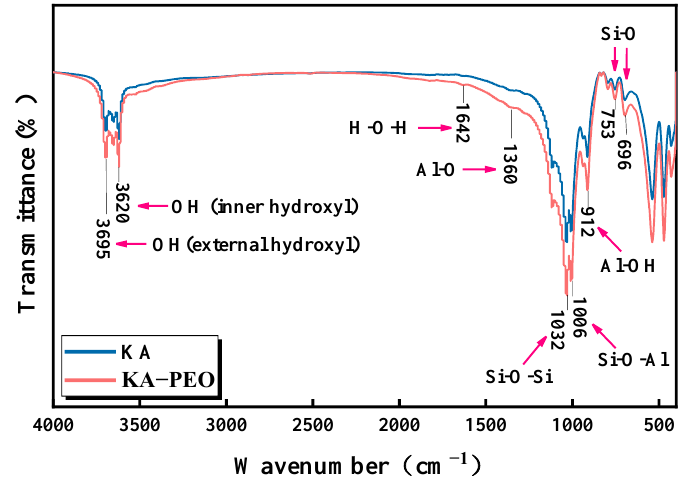
Figure 11. FTIR spectra of kaolinite before and after PEO treatment.